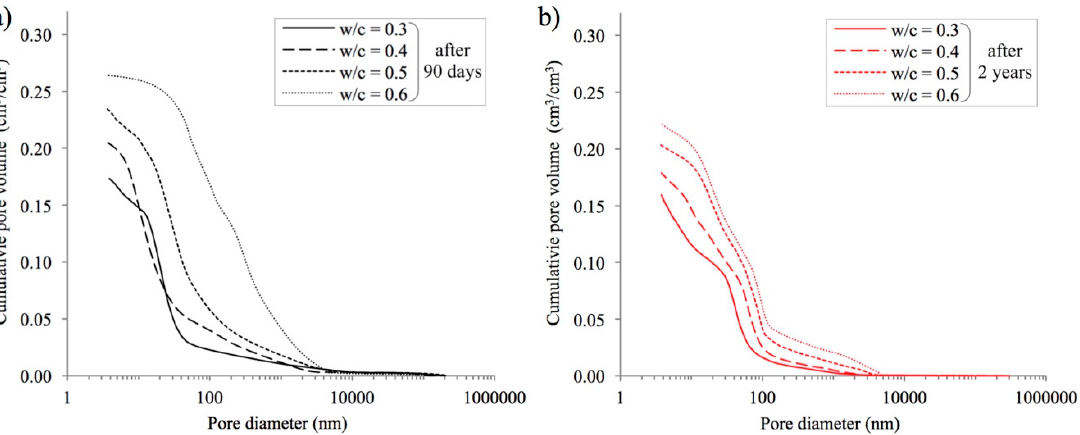
Figure 5. Cumulative pore distribution curves in cement pastes with different w/c ratios after 90 days ( a ) and 2 years of curing ( b ).